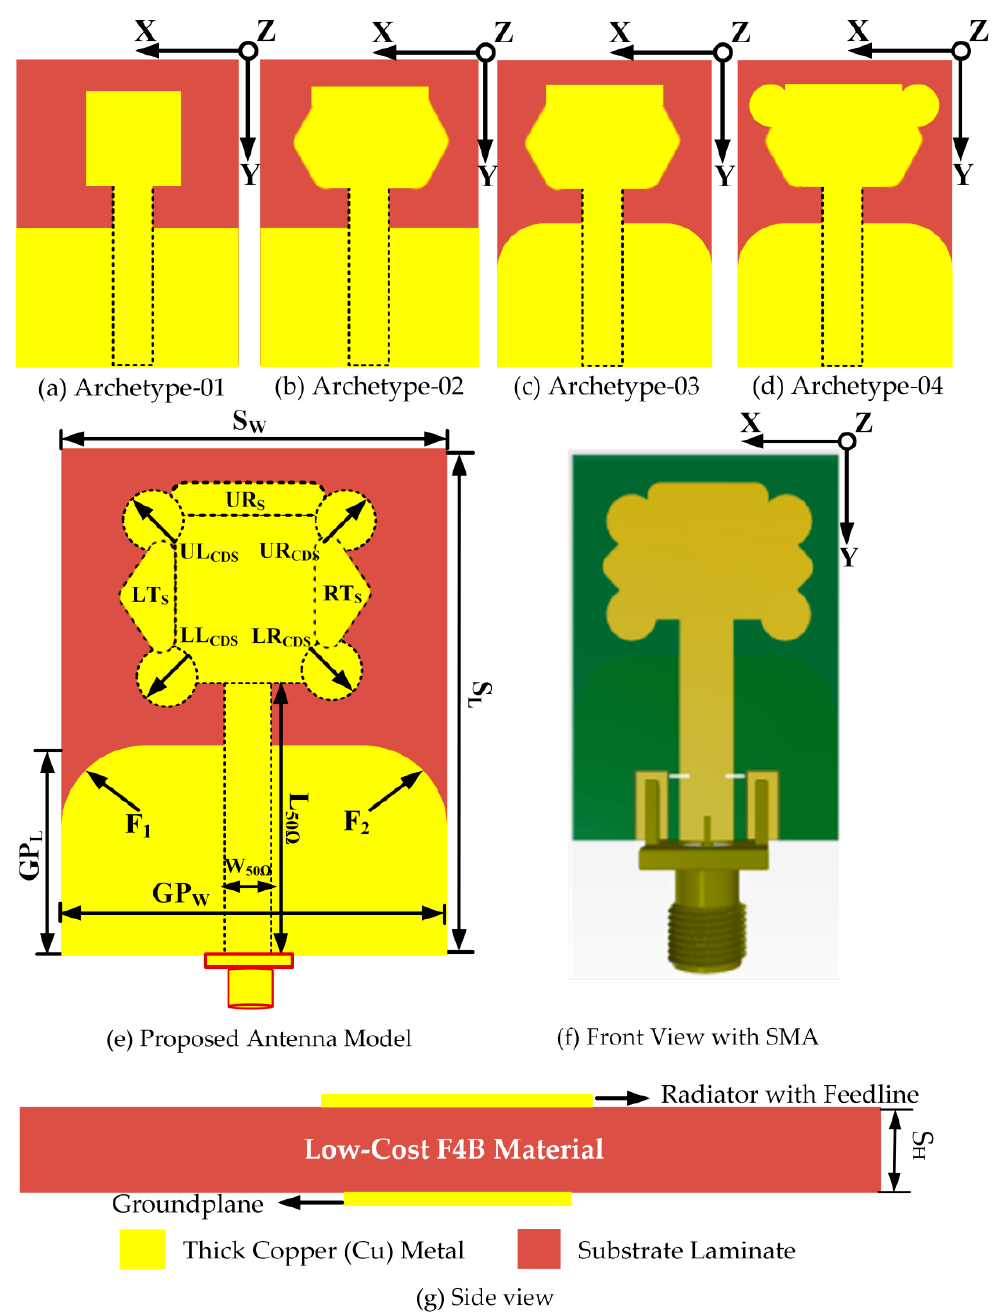
Figure 1. Diagram of the process of the antenna: ( a ) feeding the square patch with a partial ground plane, ( b ) a modified patch loaded with a stub, ( c ) a modified patch with a chamfered partial ground plane, ( d ) a loaded patch with a disc-shaped stub, ( e ) a top and back view of the proposed antenna, and ( f ) a 3D model of the designed antenna and ( g ) side view of the proposed antenna. entire frequency range. The first designed antenna model achieved a bandwidth (BW) of 2.19 GHz with a return loss of 10 dB, ranging from 4.0–6.19 GHz, which can be observed in the